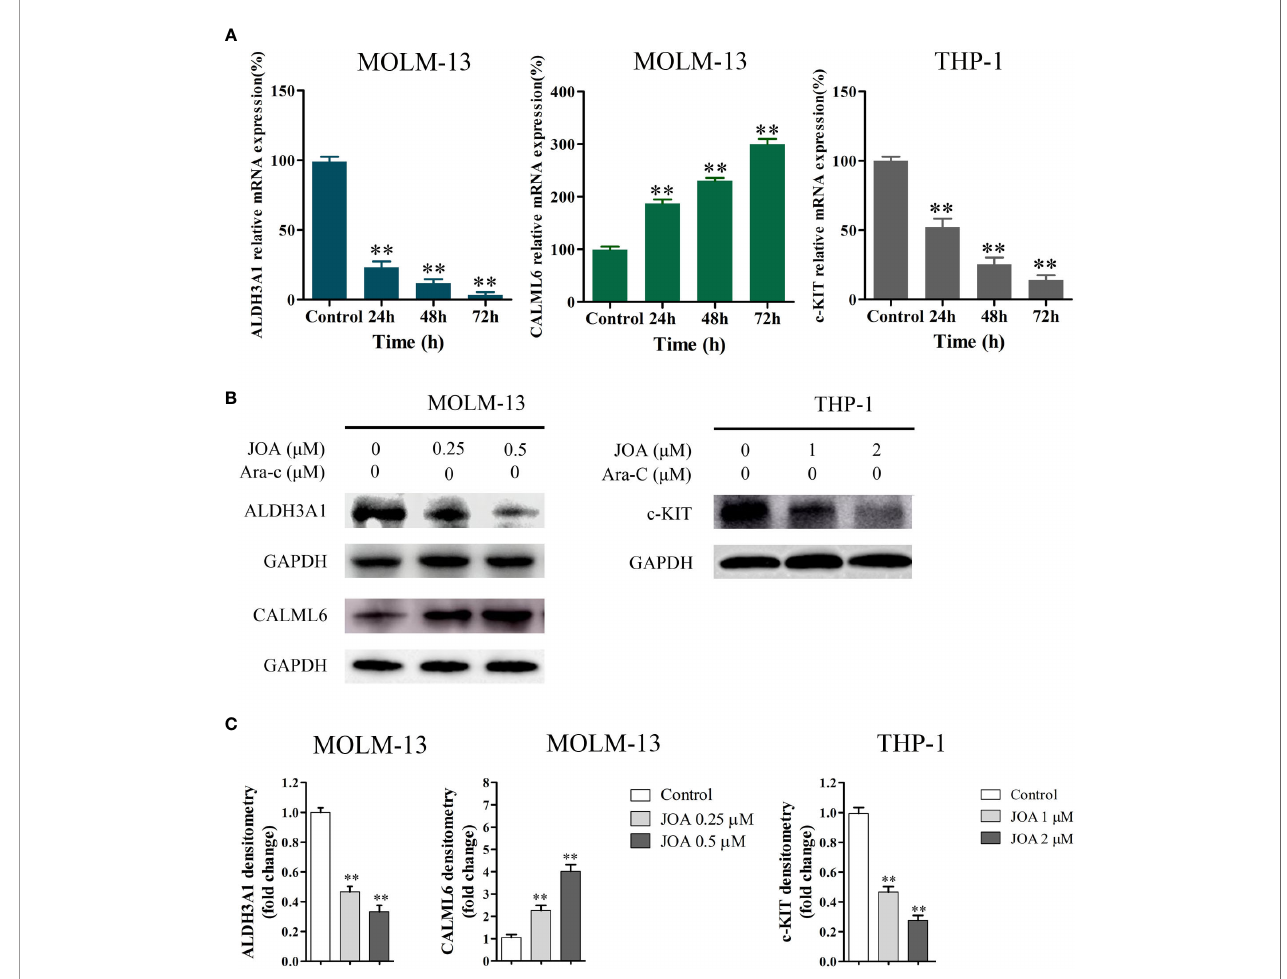
FIGURE 7 | The RT-PCR and Western blotting analysis of DEGs in MOLM-13 and THP-1 cells. (A) The effects of JOA on the mRNA expression of ALDH3A1, CALML6 and c-KIT evaluated by RT-PCR (B) ALDH3A1, CALML6 and c-KIT protein levels measured by Western blotting analysis. (C) Graph bars show the protein expression visualized and quanti fi ed by AI600 imager. MOLM-13 and THP-1 cells were incubated with 0.5, or 2 m M JOA for 72 h, respectively. (**p < 0.01). The fi gures are representative of four independent